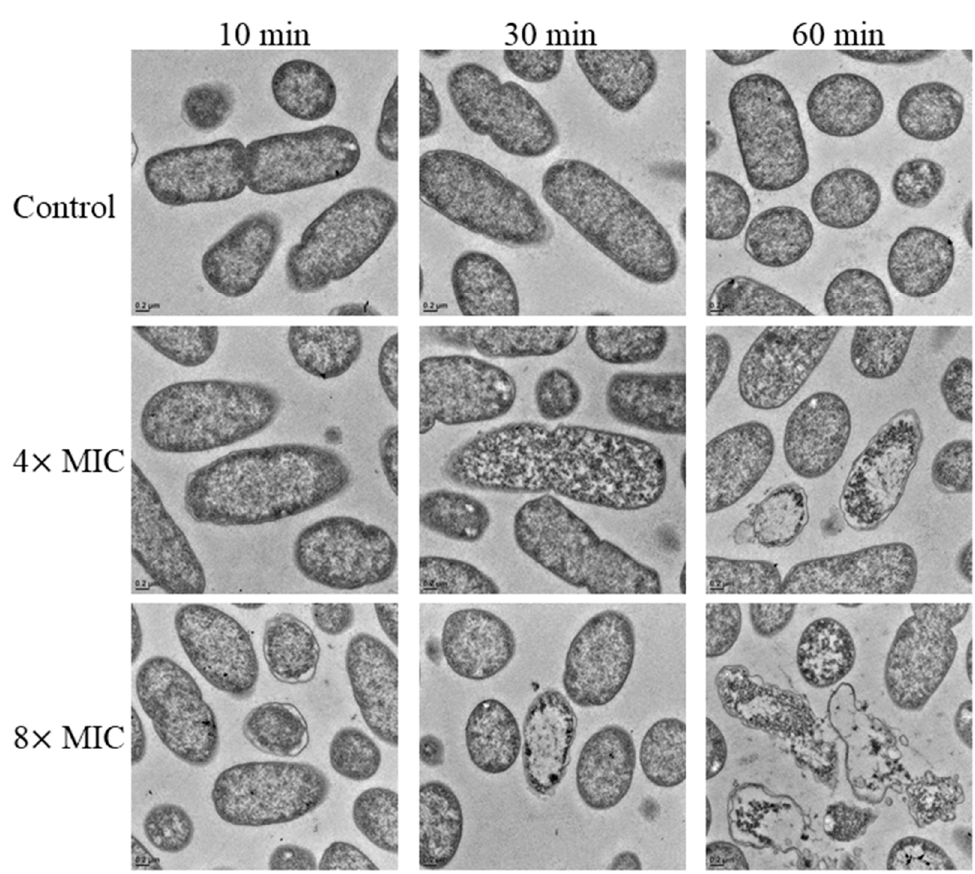
Figure 5. Transmission electron microscopy images of 2 × 10 9 CFU/mL of MDR ETEC left untreated (control) or treated with Q4-15a-1 of 4× or 8× MIC (16 or 32 μ g/mL) for 10, 30, or 60 min. Scale bars, 0.2 μ m.